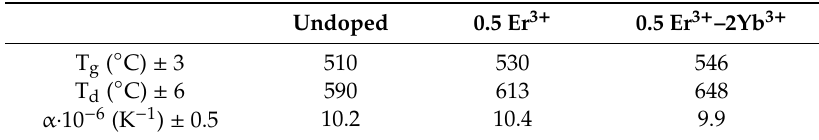
Table 1. Glass transition temperature (T g ), dilatometric softening temperature (T d ) and coefficients of thermal expansion ET ( α ) as a function of the RE 3+ concentration (in mol%).